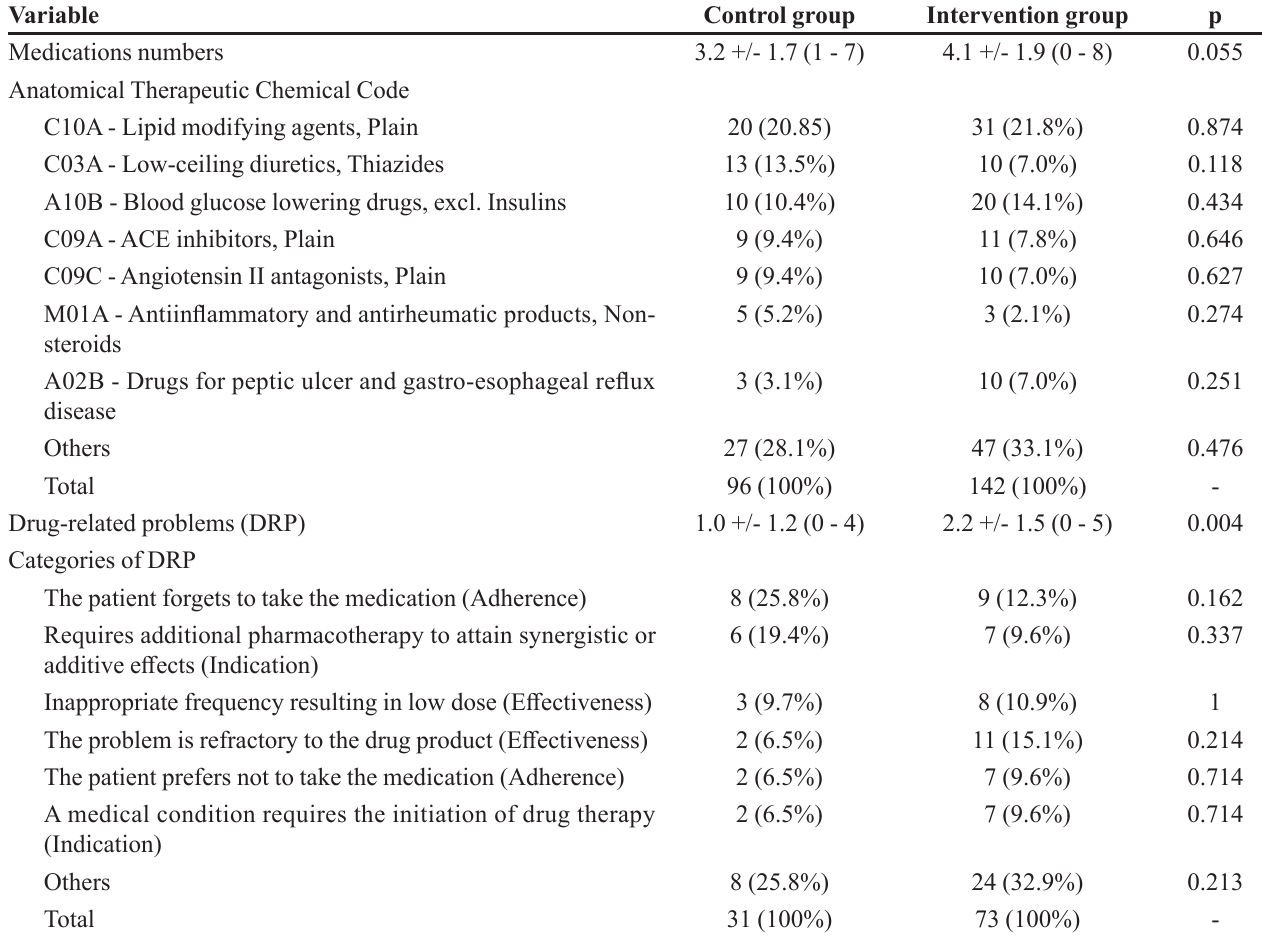
TABLE II - Initial therapeutic profile and DRP of control and intervention group, n (%), mean ±